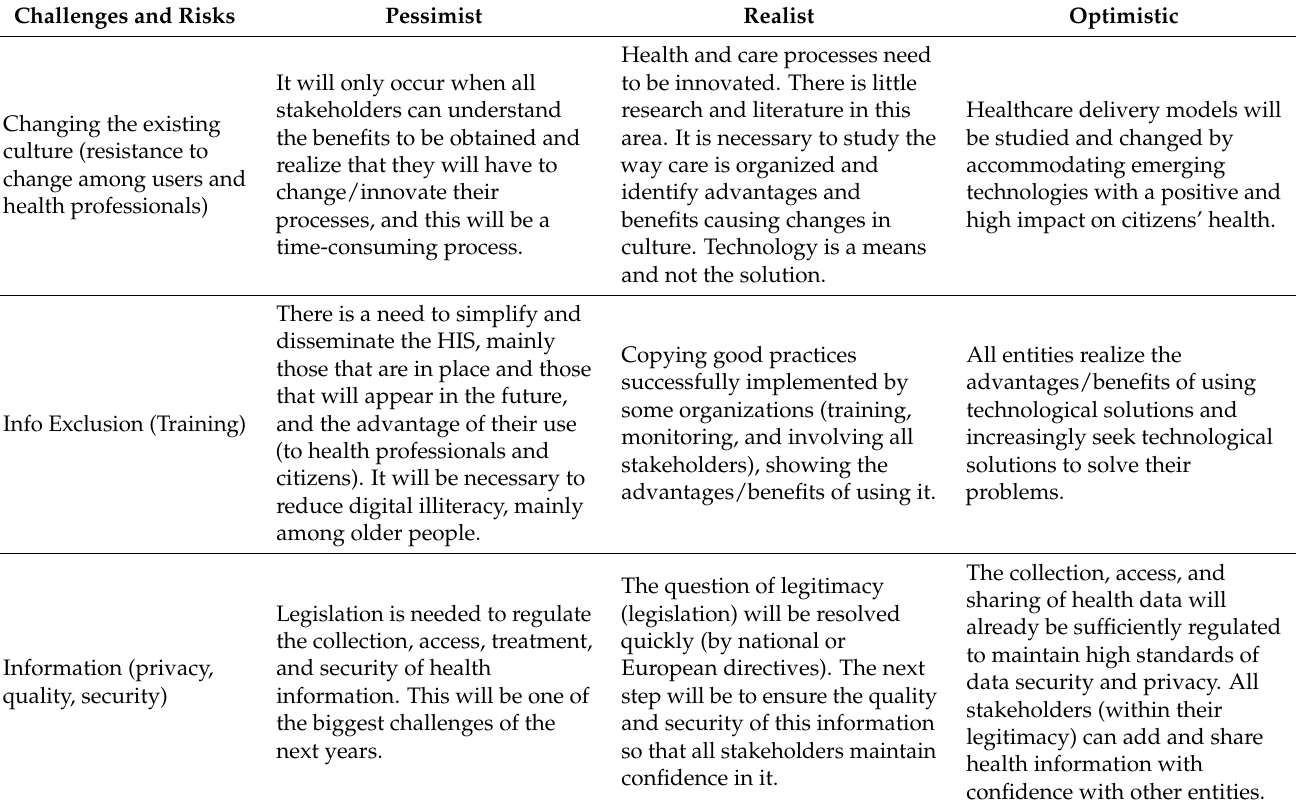
Table 5 outlines the scenarios related to Challenges and Risks. Table 5. Scenarios for Challenges and Risks.